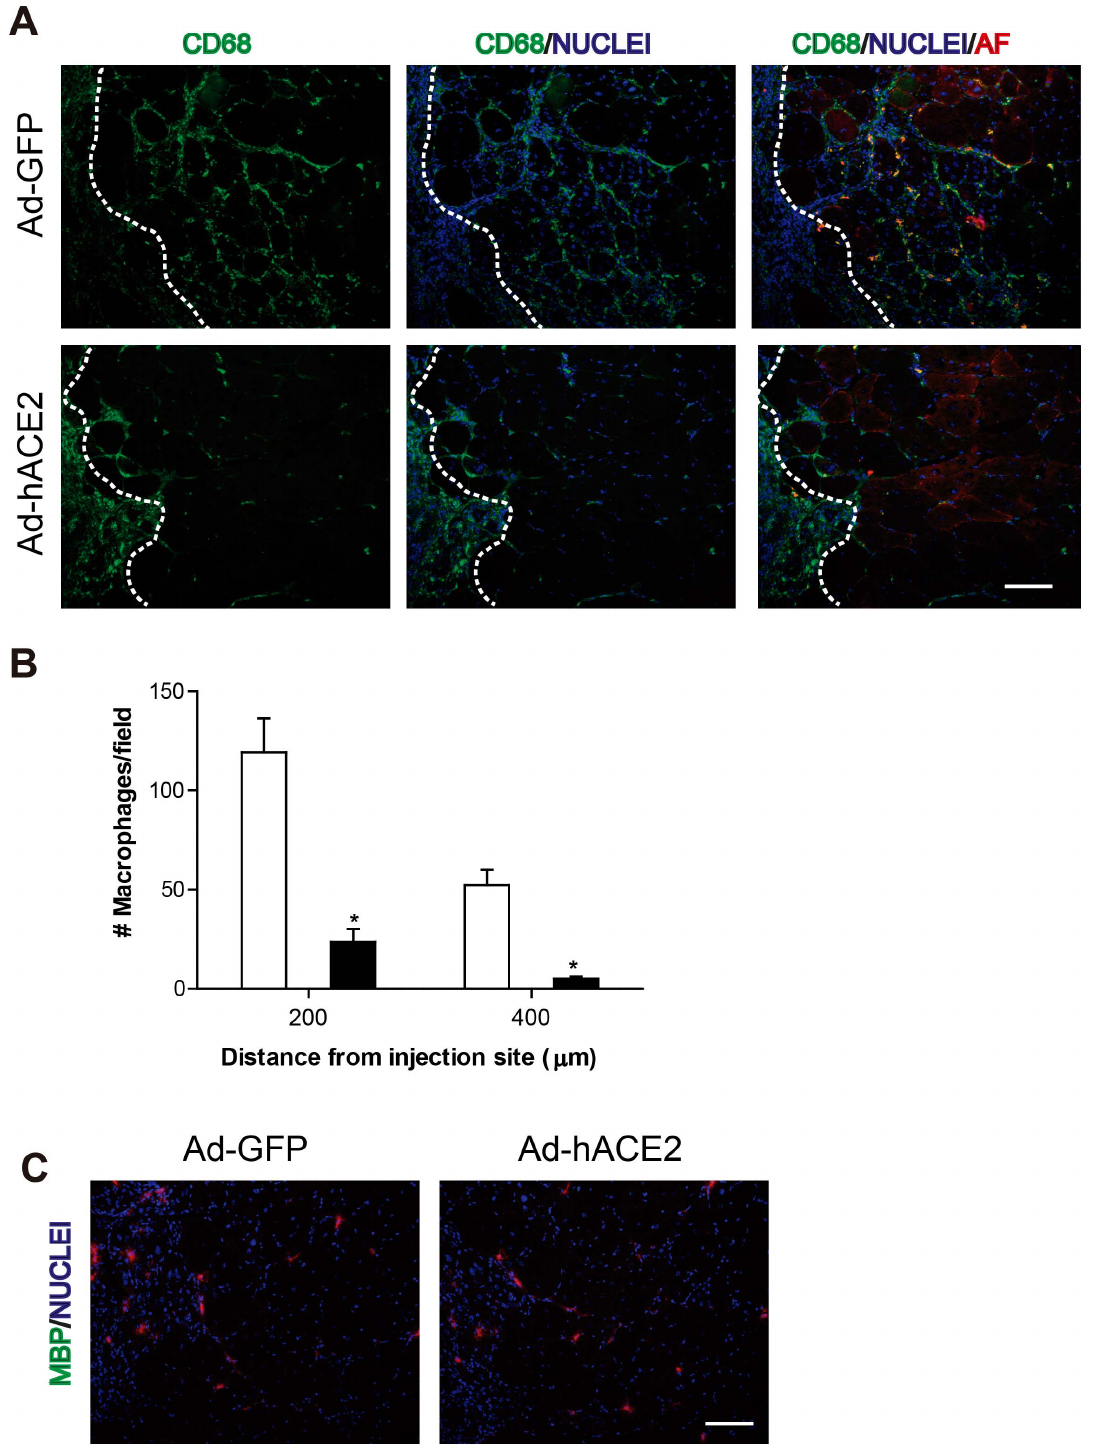
Figure 6. ACE2 overexpression reduces macrophage infiltration in dystrophic muscles. (A) To evaluate the direct effect of ACE2 in vivo , TA muscles from mdx mice were injected with Ad-GFP or Ad-hACE2 and analyzed after 5 days by immunofluorescence using anti-CD68 antibody (green) to determine macrophage infiltration 200 m m from the injection site (delimitated area). Nuclei were stained with Hoechst and as a reference point the muscles were overexposed to visualize the muscle fibers (red). (B) Quantification of macrophage infiltration into the muscle at 200 and 400 m m from the injection site. Infiltration in Ad-GFP injected muscle (white bars) and Ad-hACE2 (black bars) was compared. (C) Immunofluorescence staining with anti-major basic protein antibody to determine the number of eosinophils present in the muscle after injection. Nuclei were stained with Hoechst. Bar 100 m m.